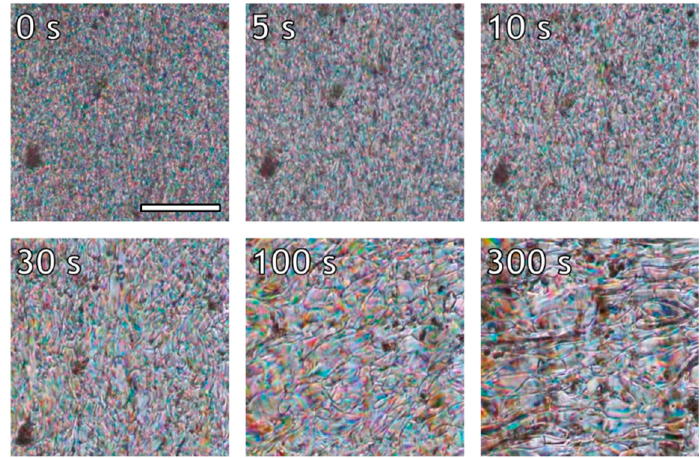
Polymers 2018 , 10 , x FOR PEER REVIEW 8 of 18